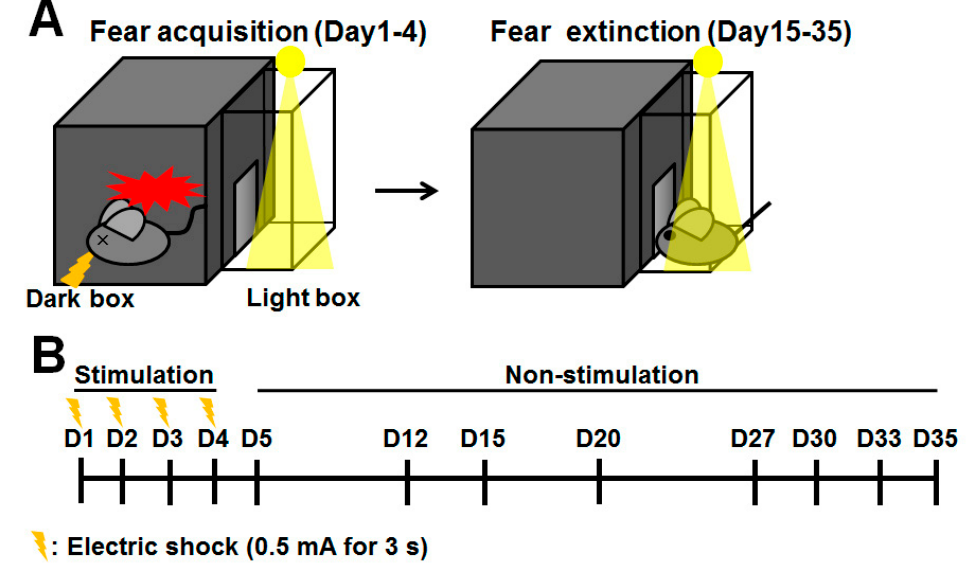
Figure 1. Experimental apparatus and design for evaluation of fear extinction. ( A ) Schematic diagram of contextual fear memory in passive avoidance task to evaluate fear extinction in the mouse. ( B ) Experimental schedule for assessment of fear extinction. Mice received an electric shock (0.5 mA for 3 s) once a day for four consecutive days (fear acquisition). After that, the mouse was exposed to the light box, and step-through latency was measured without an electric shock (fear extinction). D: Day.